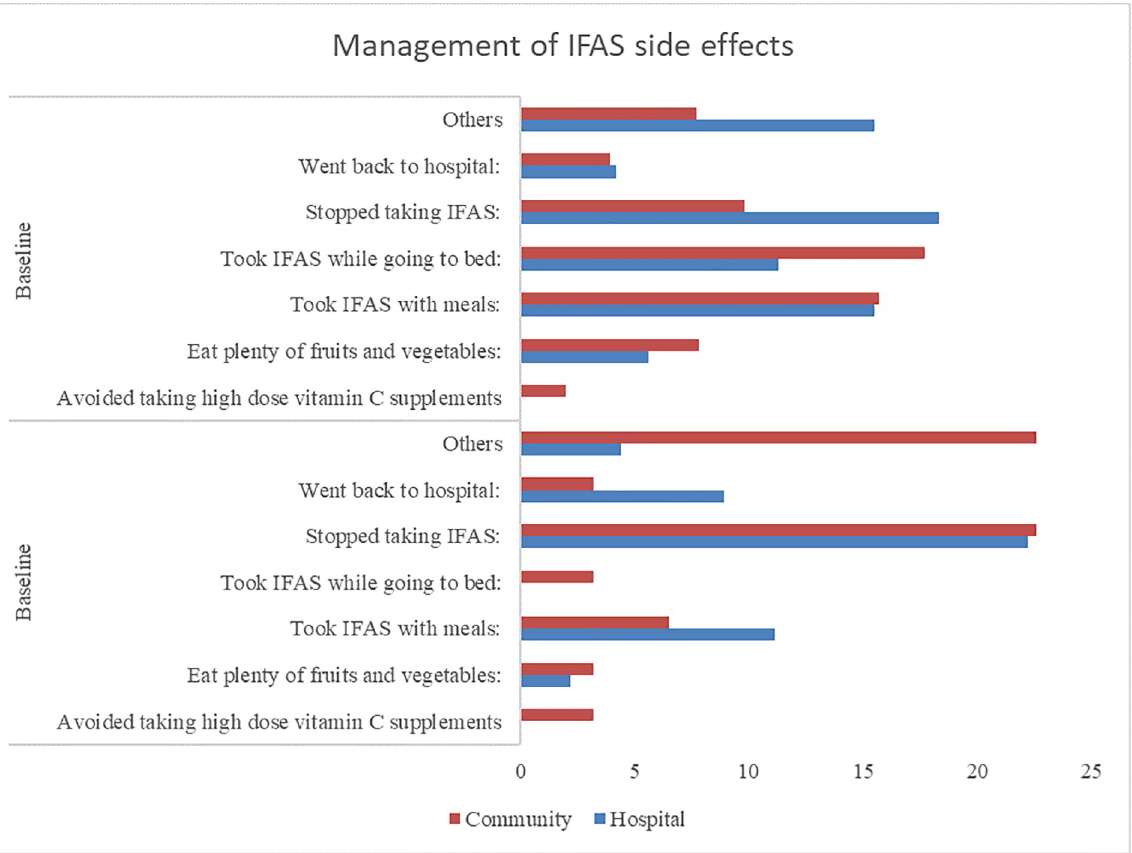
Fig 4. Mitigation measures of IFAS side effects by pregnant women. This refers to the measures that pregnant women taking IFAS used to mitigate IFAS side effects whenever they experienced them, at both baseline and endline for both the control (hospital) and intervention (community)